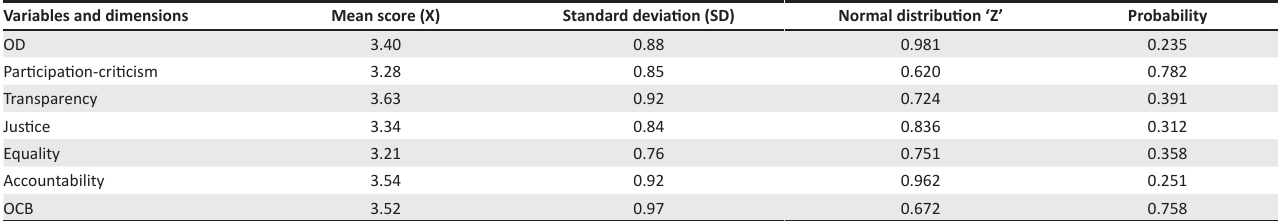
TABLE 2: Organisational democracy and organisational citizenship behaviour Kolmogorov–Smirnov test results. Variables and dimensions